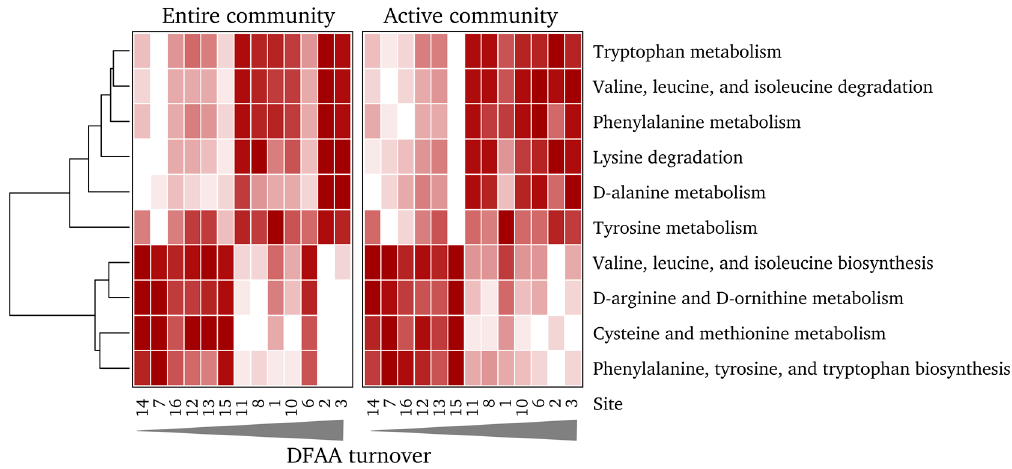
Figure 6. Abundance of KEGG pathways putatively involved in amino acid metabolism and significantly linked to DFAA turnover. White: low relative abundance; red: high relative abundance. Numbers correspond to sampling stations.